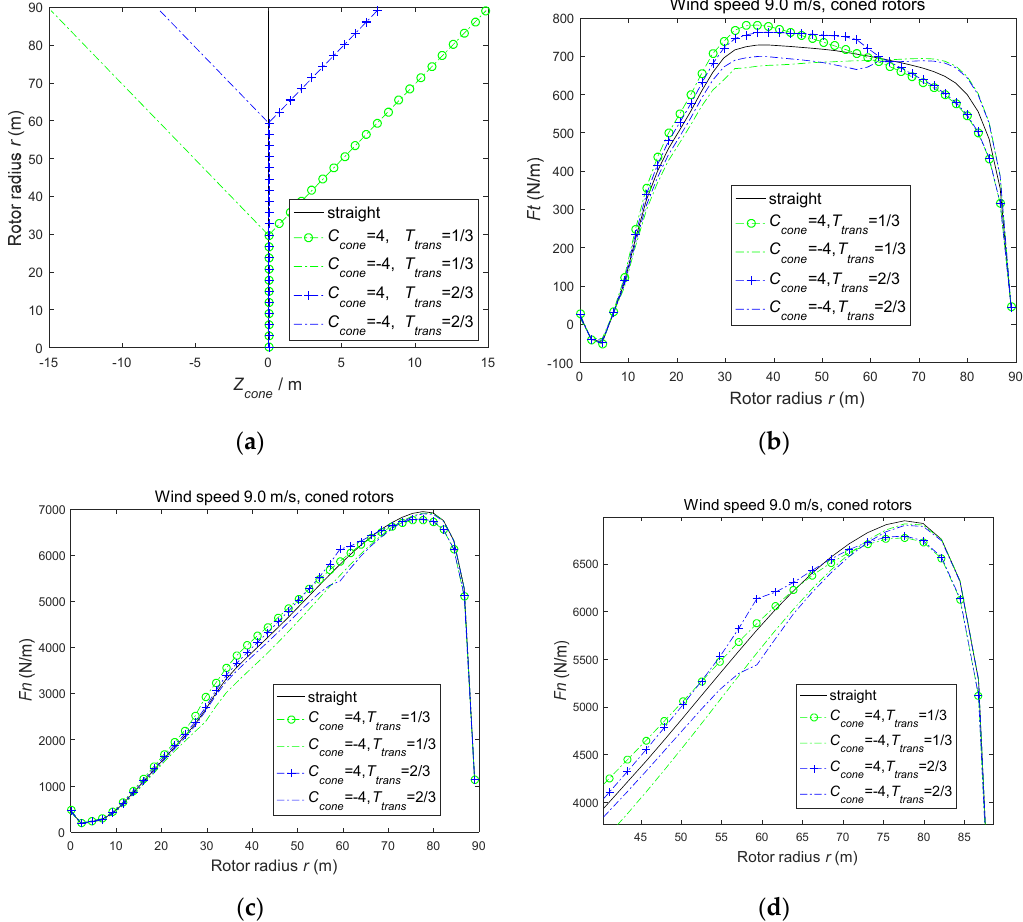
Figure 10. Comparisons of rotors with T trans = 1 / 3, 2 / 3: ( a ) conning configurations; ( b ) tangential force; ( c ) normal force; ( d ) magnified view of normal force.